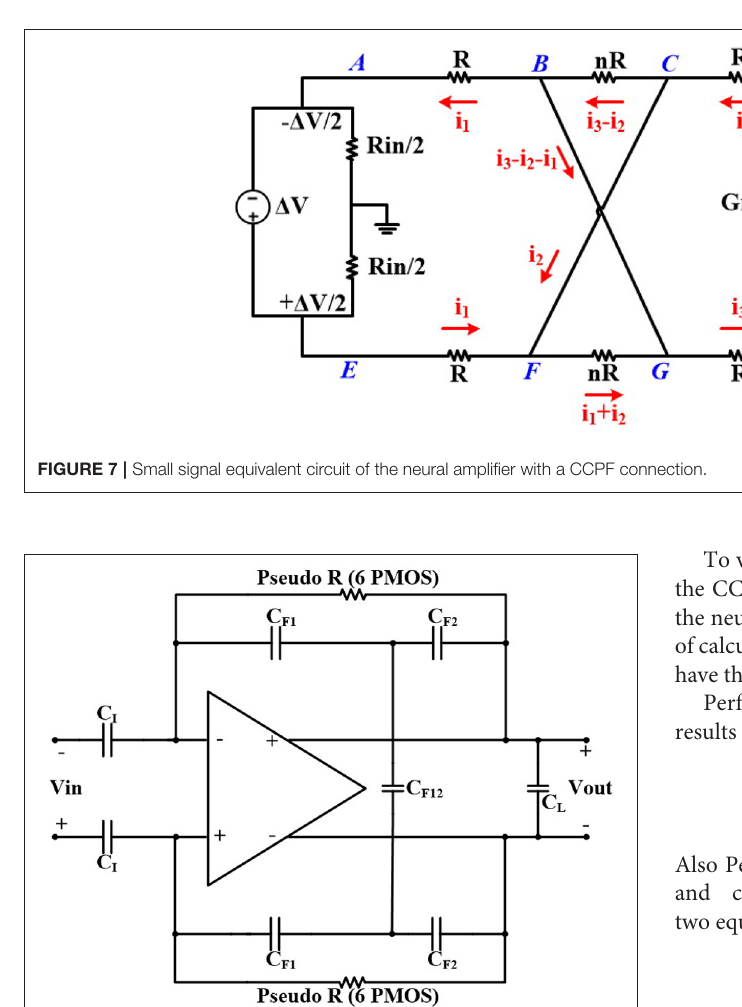
FIGURE 8 | T-capacitor feedback network architecture with